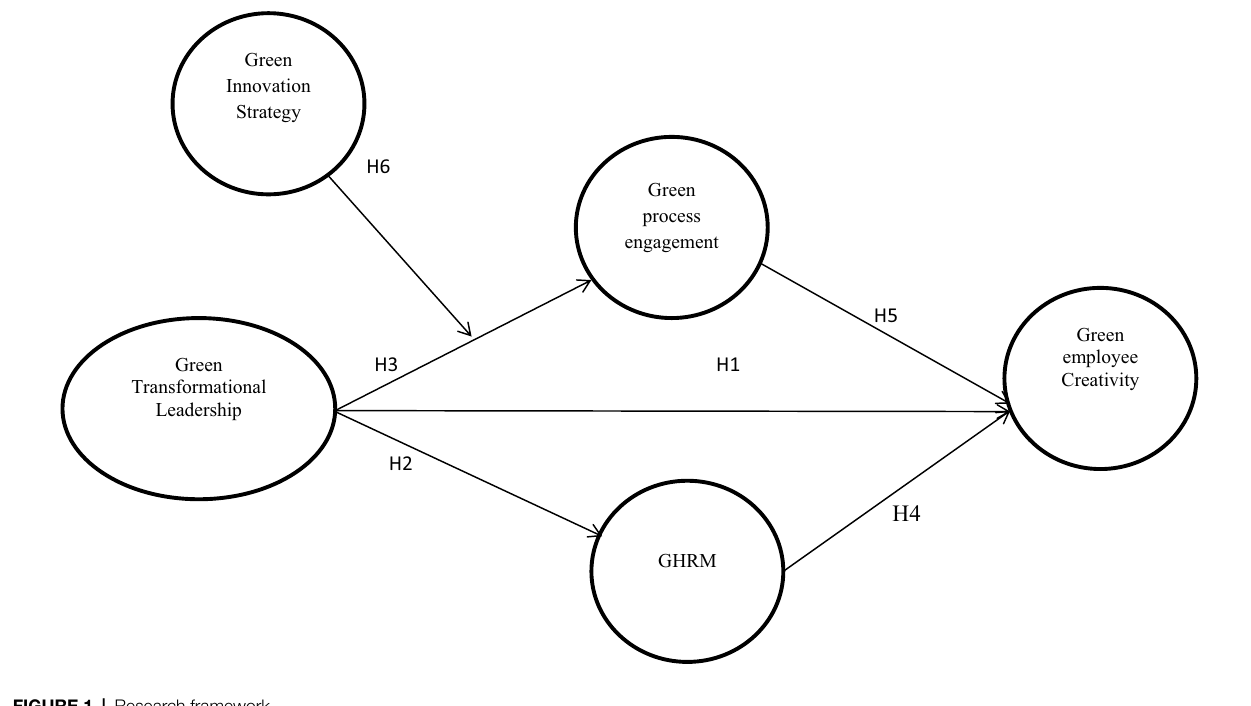
FIGURE 1 | Research